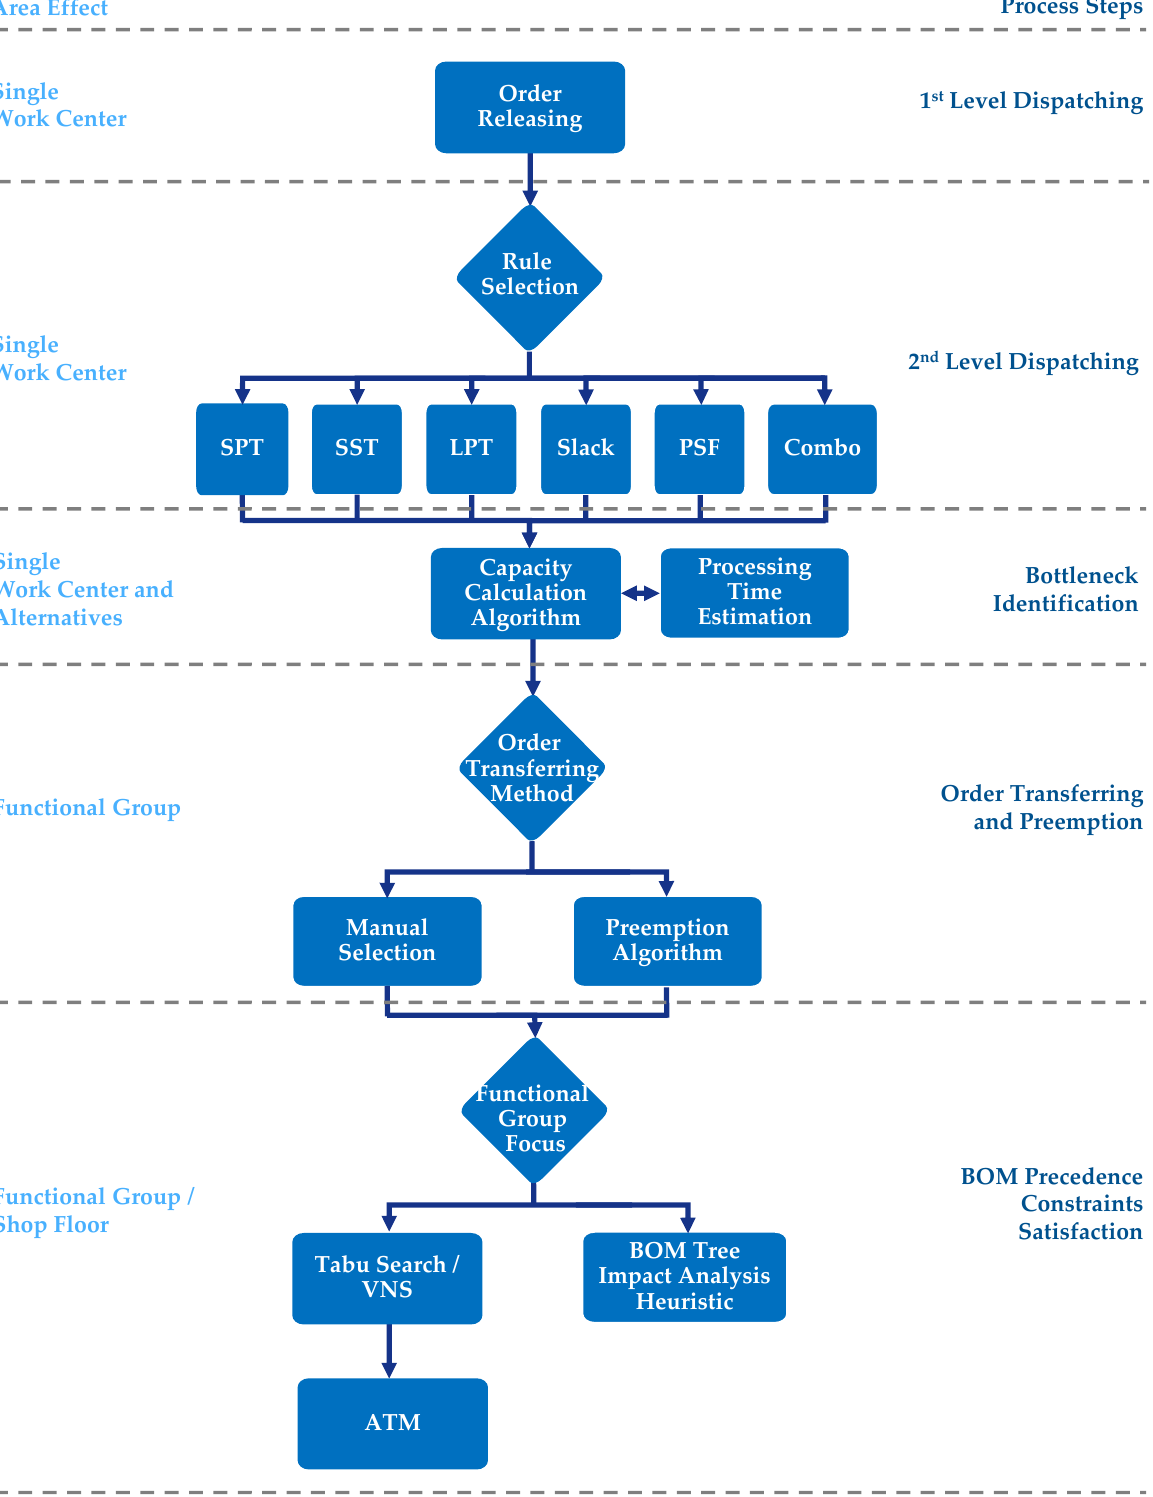
Figure 2. Algorithms for core DSS functionality.